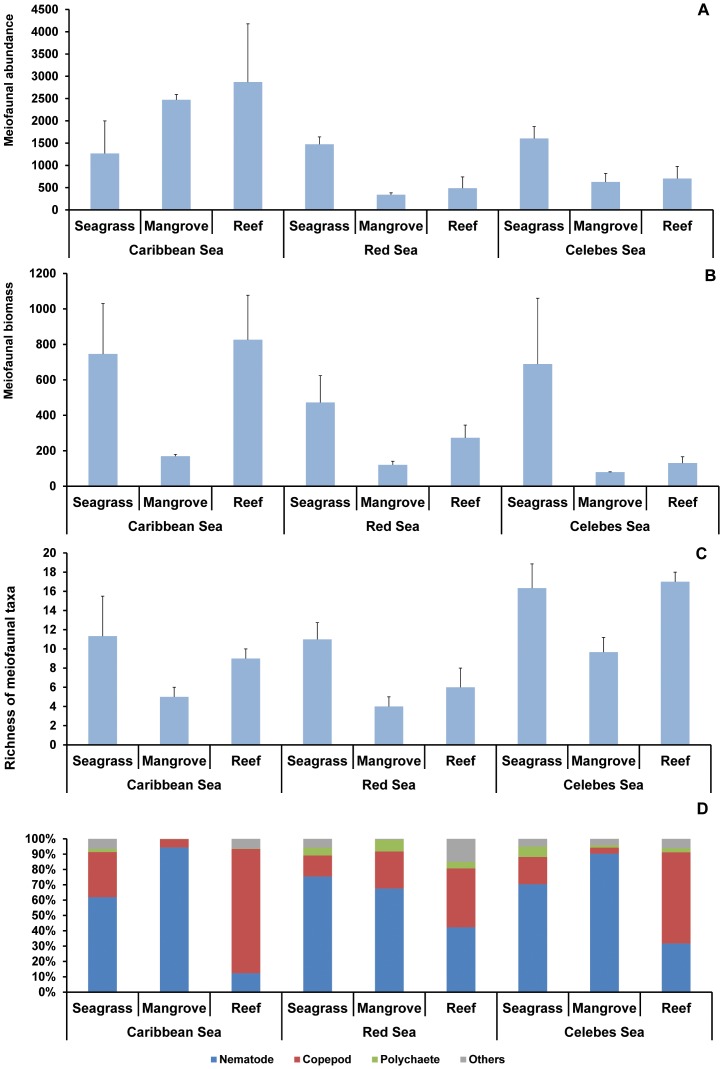
Meiofaunal assemblages.Illustrated are meiofaunal: A) abundance (ind 10 cm−2), B) biomass (µgC 10 cm−2), C) richness of taxa, and D) assemblage composition in seagrass, mangrove and reef habitats of the Caribbean, Red and Celebes Seas. Reported are average values ± standard deviation.